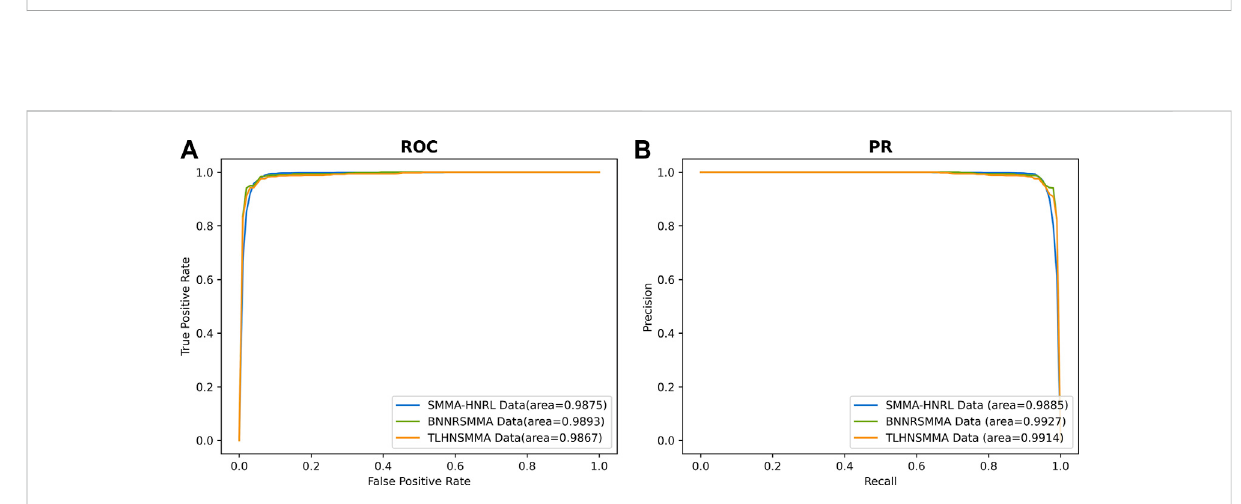
FIGURE 7 The ROC curves (A) and PR curves (B) of SMMA-HNRL in robustness